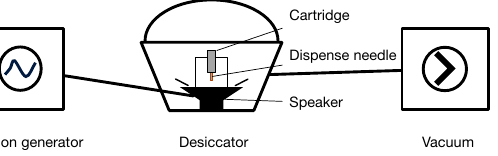
Figure 2. Schematic of the degas-desiccator to remove gas from the adhesive after